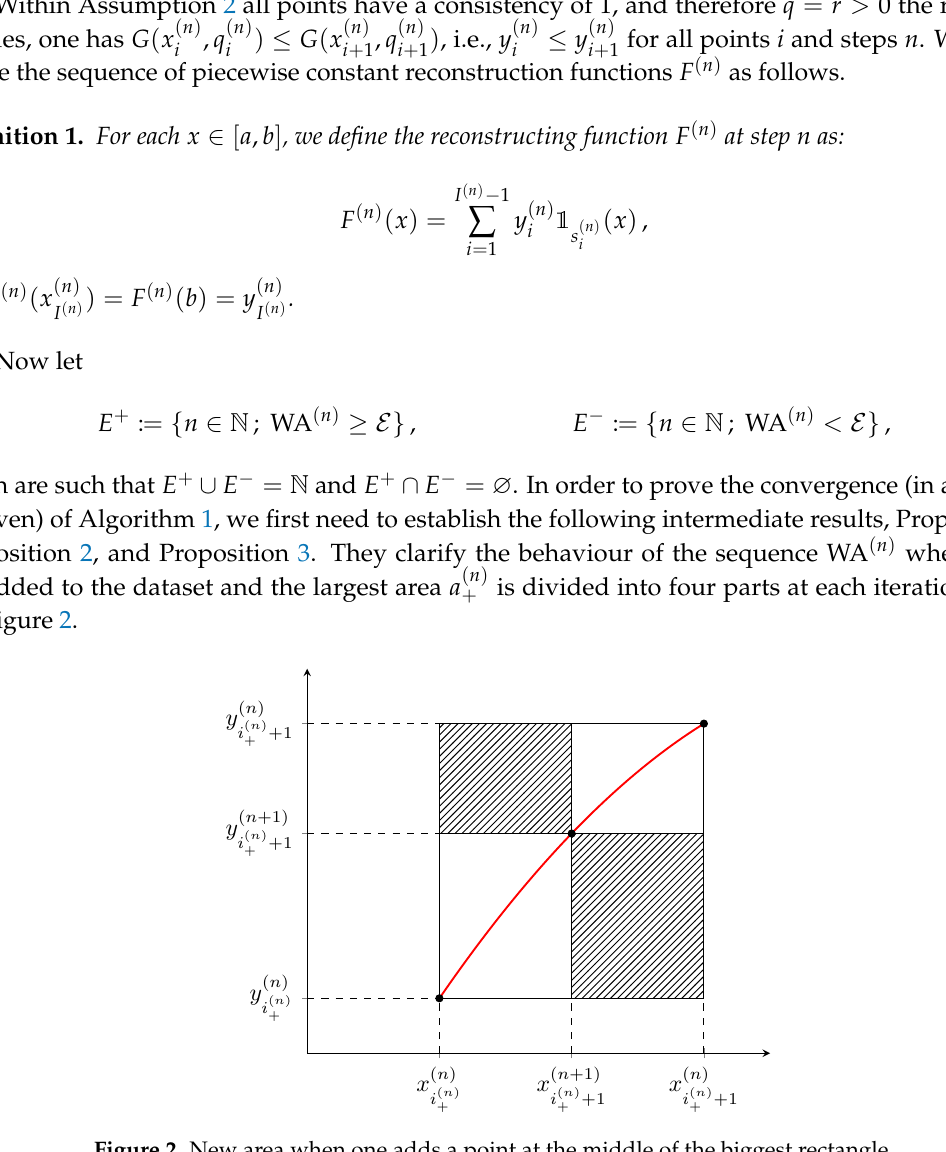
Figure 2. New area when one adds a point at the middle of the biggest